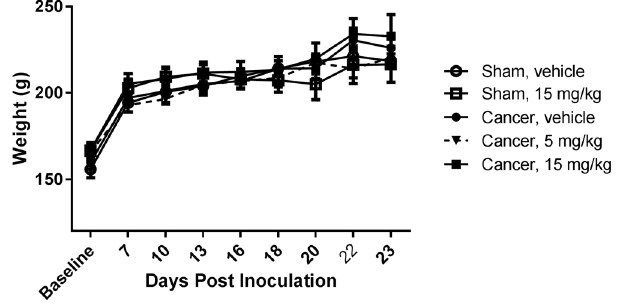
Figure 8. Dasatinib did not lead to loss of body weight. Two-way repeated-measurement ANOVA followed by Bonferroni’s multiple comparison test did not reveal any statistically significant differences among cancer bearing and sham-operated animals or between the dasatinib-treated groups (p < 0.05). Data are displayed as mean ± SEM, n =